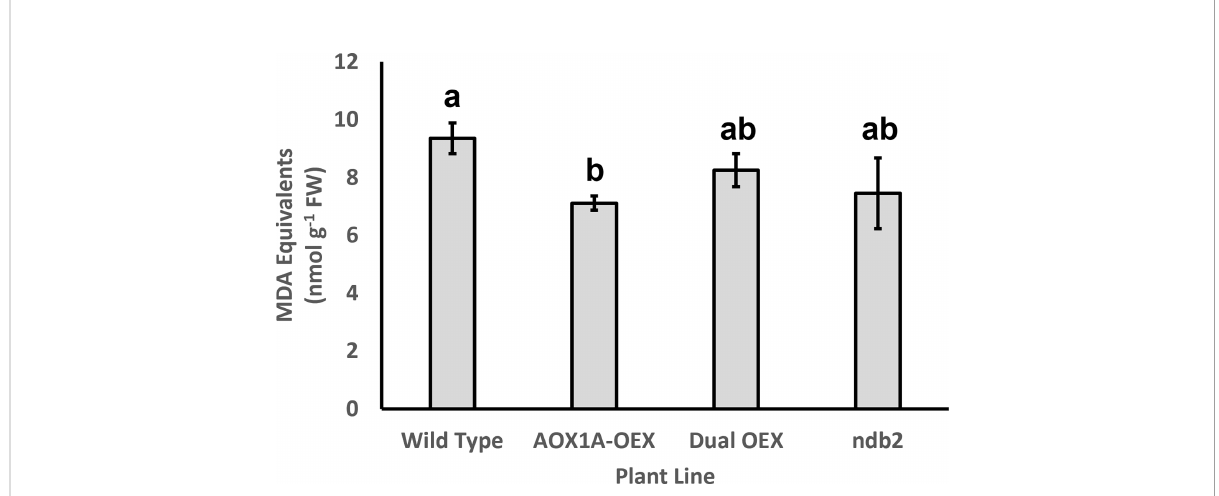
FIGURE 5 Effect of altered AOX1A and NDB2 expression on lipid peroxidation levels. Malondialdehyde equivalents were measured using a TBARS assay (Hodges et al., 1999), from aliquots of the powdered leaf samples used for RNA extractions. Columns represent means (n = 3 ± S.D.). Statistical signi fi cance indicated by different letters, based on one-way ANOVA with post-hoc Bonferonni-corrected pairwise comparison (corrected p <